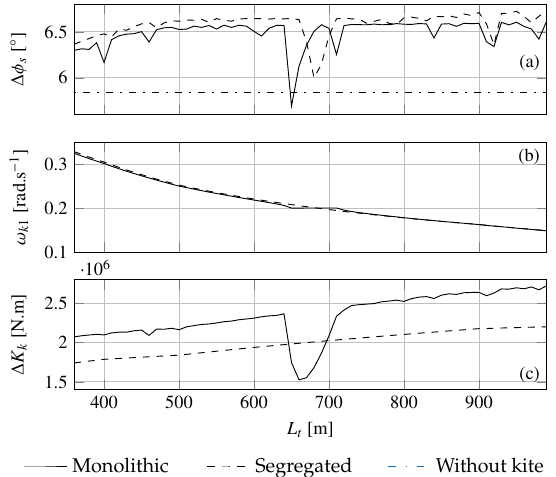
Figure 15. ( a ) Amplitude of the ship roll motion, ( b ) first kite harmonic frequency and ( c ) amplitude of the kite moment of excitation for different tether lengths from 360 m to 990 m by step length of 10 m with a beam regular wave of 2.5 m high at a frequency of ω w = 0.56 rad.s − 1